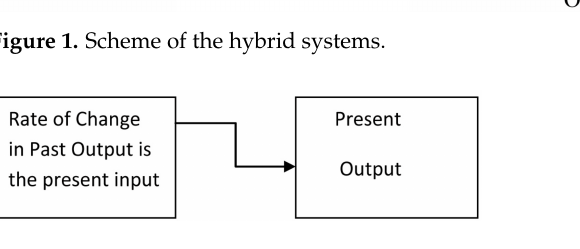
Figure 2. Scheme of the neutral delay systems.